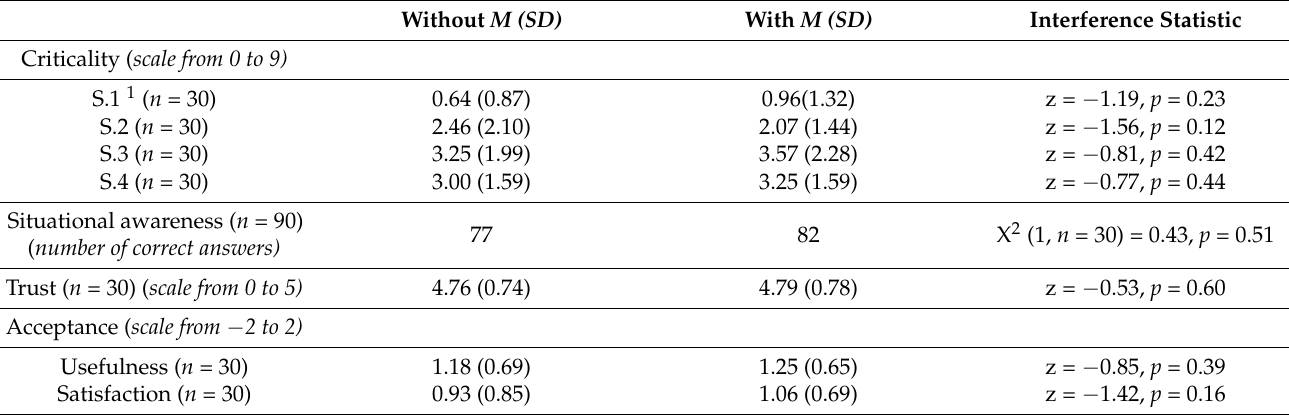
Table 4. Descriptive and inferential statistics of the evaluation of HMI with and without explanation. Without M (SD) With M (SD) Interference